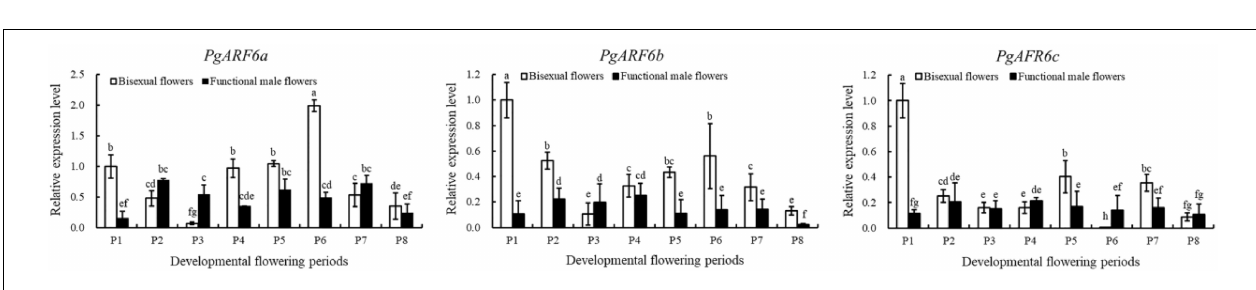
FIGURE 10 | Expression analyses of PgARF6s under IBA treatment.